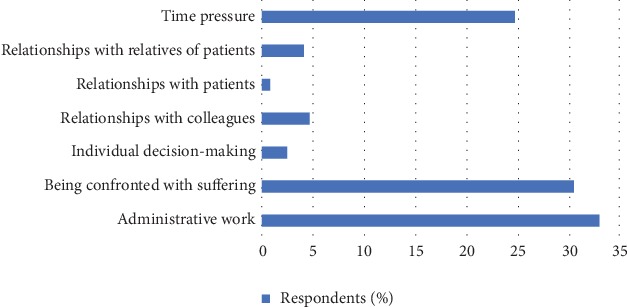
Sources of burnout.